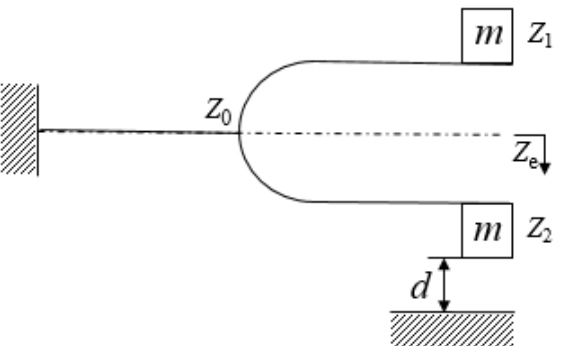
Figure 4. A schematic tuning fork structure.